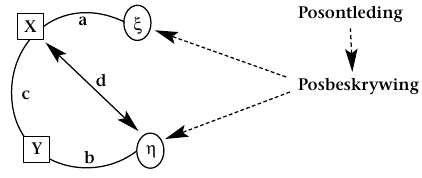
Figuur 1: Skematiese voorstelling van die afleidings wat regverdig moet word in ‘n geldigheidstudie